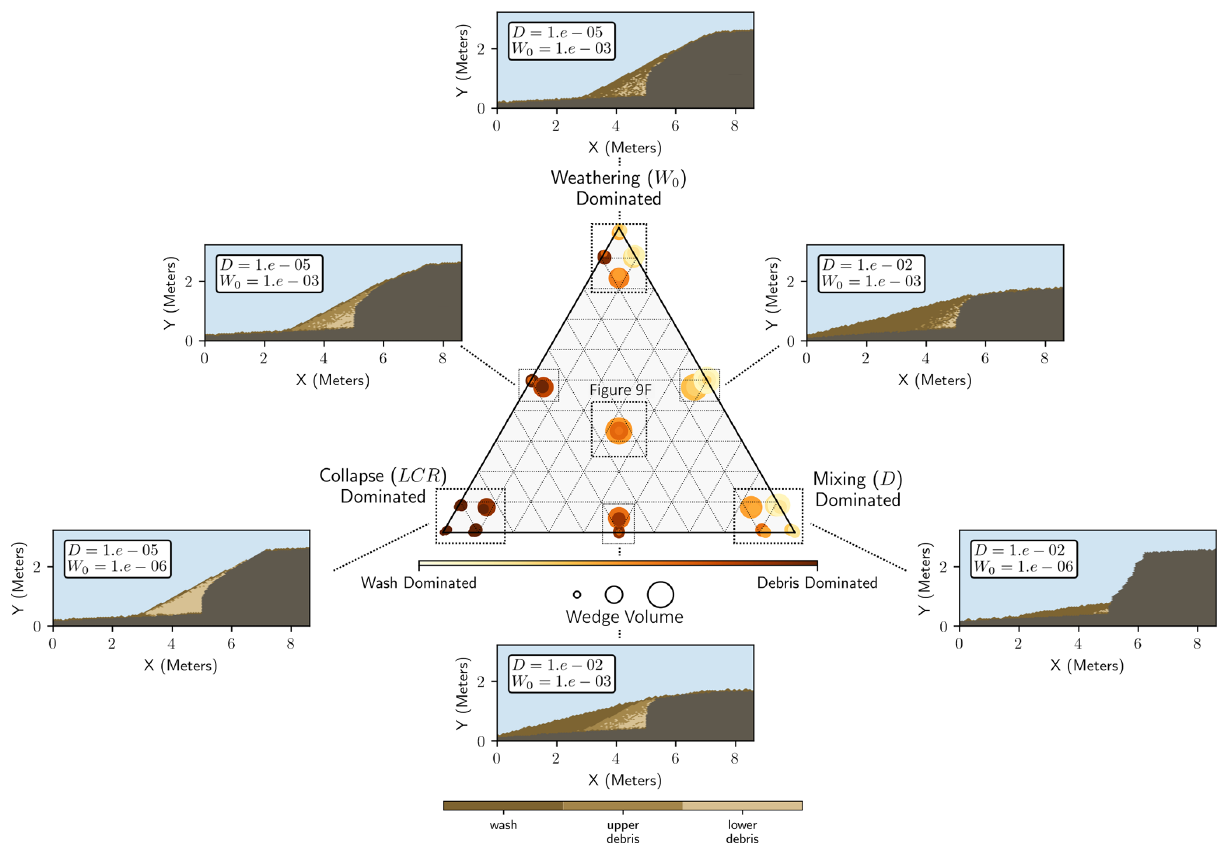
Figure 12. Summary ternary diagram of the effects of geomorphic processes on colluvial wedge morphostratigraphy for the 90 ◦ fault model following Fig. 11. Note the greater quantity of debris facies relative to the 60 ◦ fault scenarios (Fig.